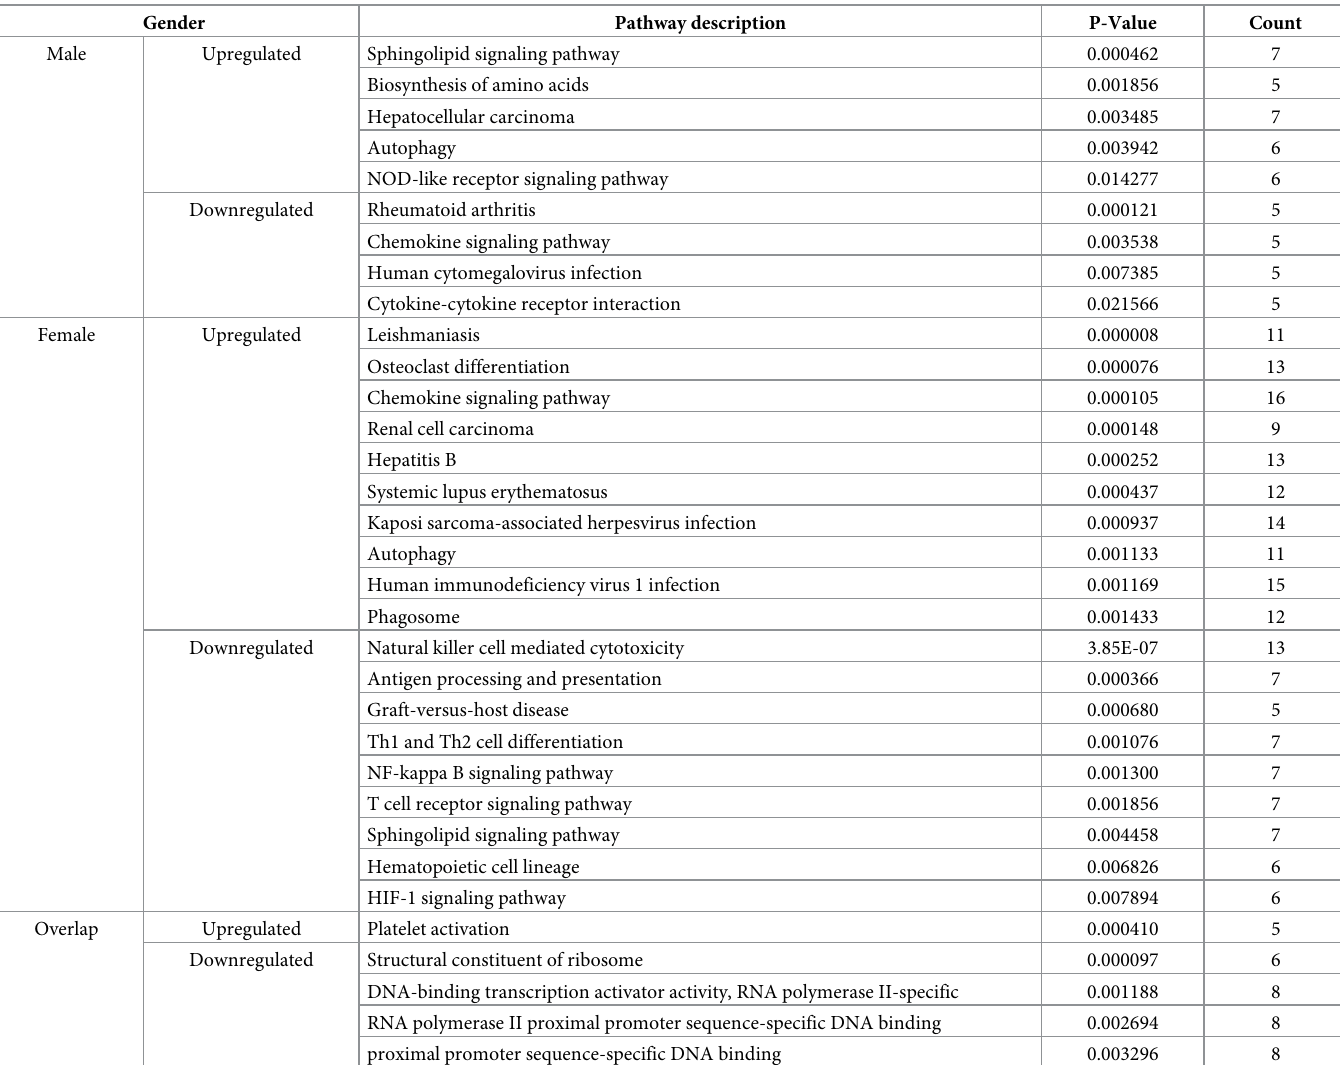
Table 1. KEGG pathway enrichment analyses for